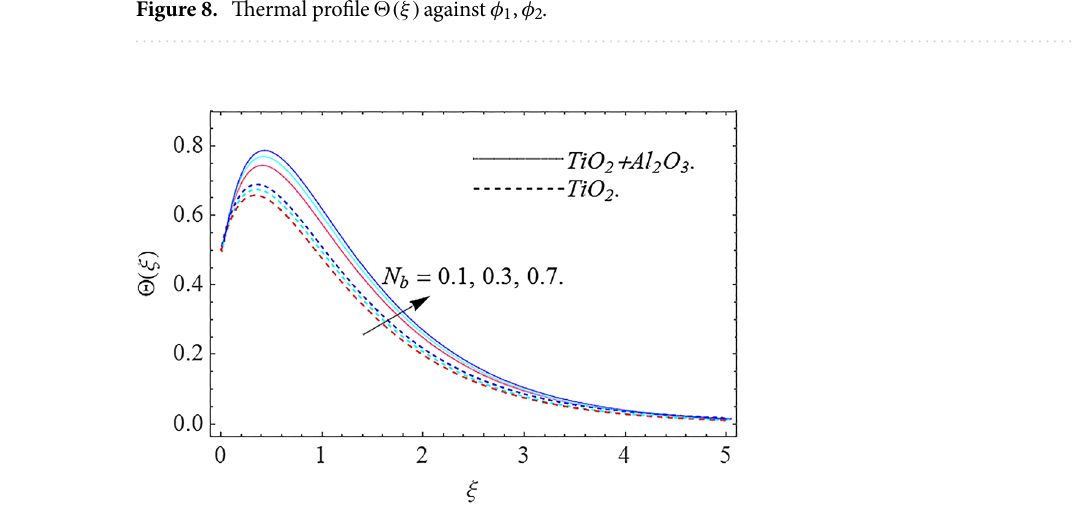
Figure 8. Thermal profile �(ξ) against φ 1 , φ 2 .